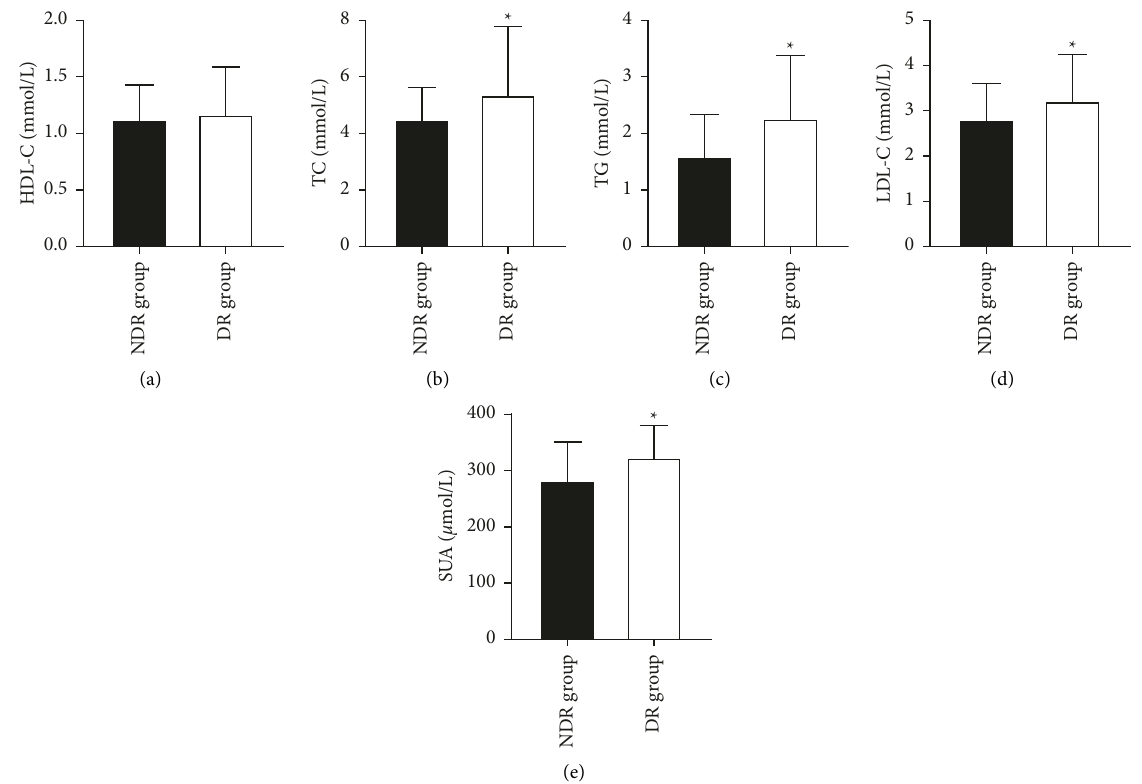
s ). (a ∼ e) HDL-C (mmol/L), TC indicates significant differences between the DR and NDR ± ∗